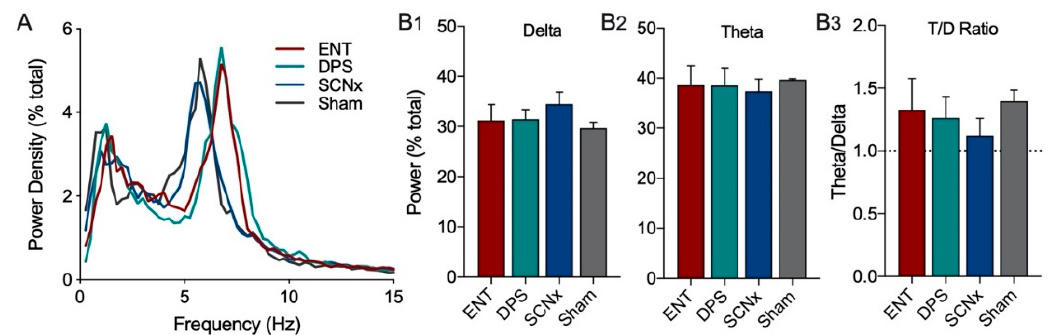
Figure 5. SCN lesions had no effect on total power in delta and theta bands during one day of object exploration. Power spectrum during exploration was similar among SCNx (n = 5) and Sham (n = 3) animals compared to ENT (n = 12) and DPS (n = 12) groups ( A ), however, peak theta frequency was ~1.0 Hz slower; for this reason, the theta band was defined as 4–7 Hz for SCNx and Sham groups. Total power in the delta ( B1 ) and theta ( B2 ) frequency bands, as well as in the T/D ratio ( B3 ) did not differ among all four groups. Data expressed as mean (±SEM).